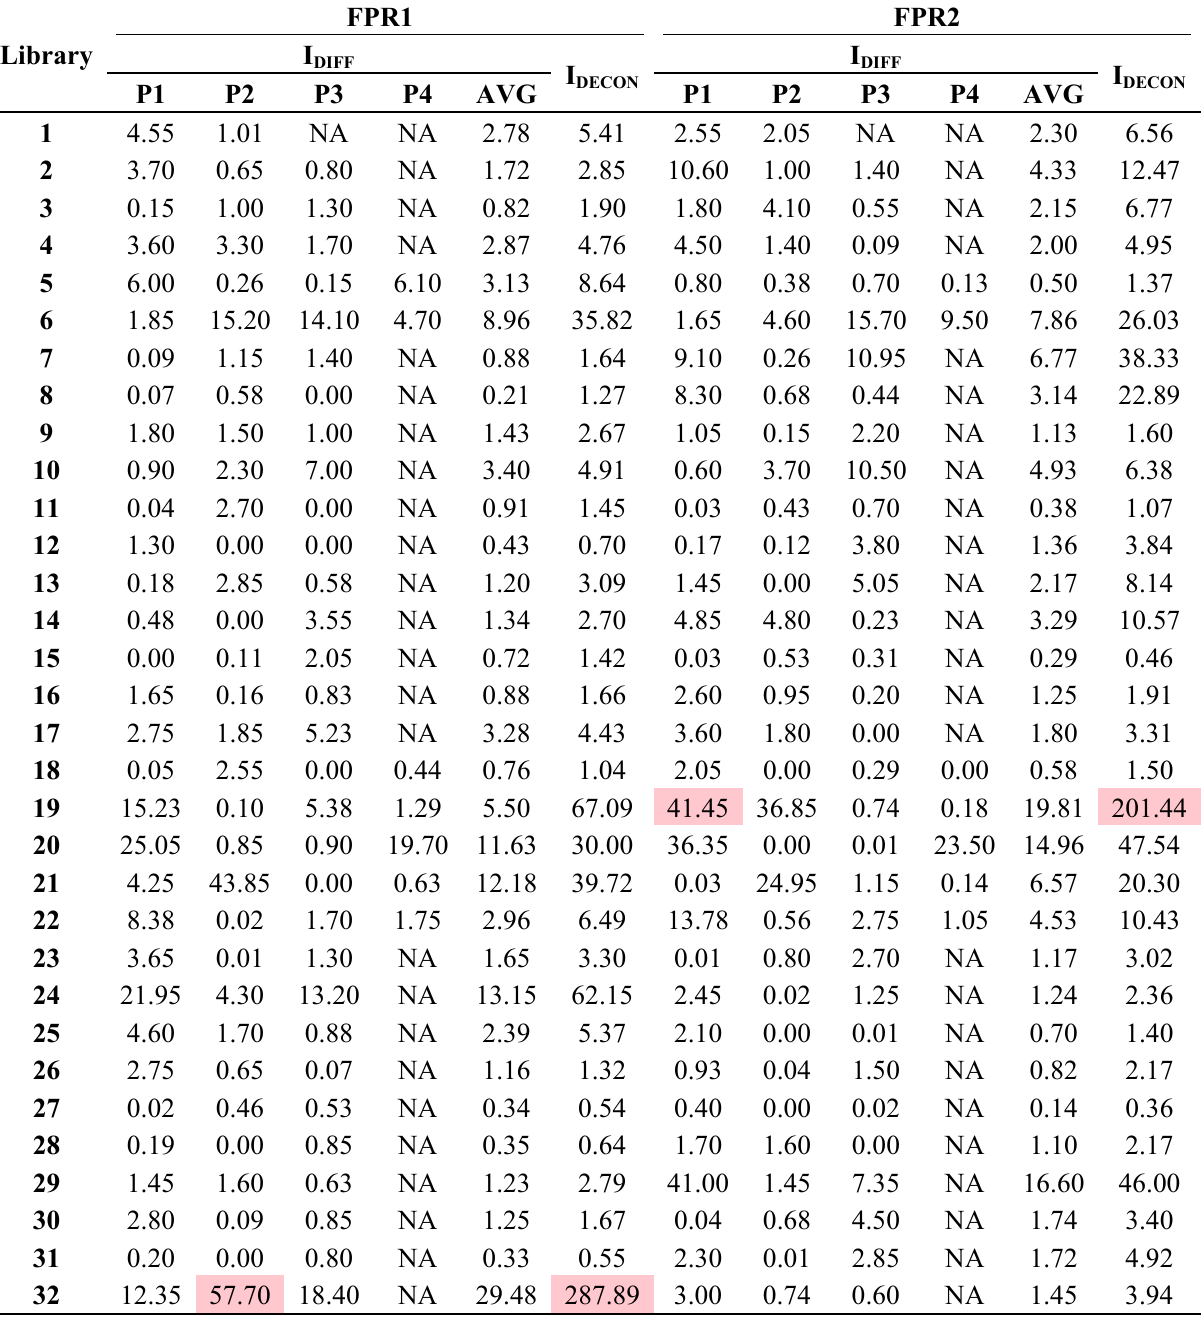
Table 2. Indices of Differentiation and Deconvolutability for the 32 libraries against both targets. The most differentiated positions and the most deconvolutable libraries are shown in